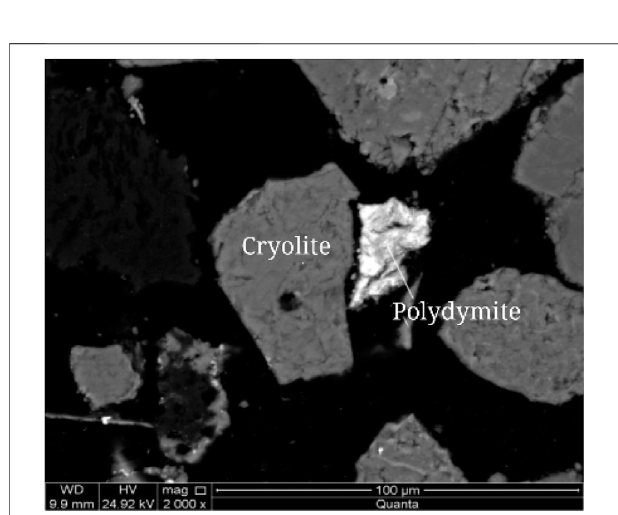
Frontiers in Materials |